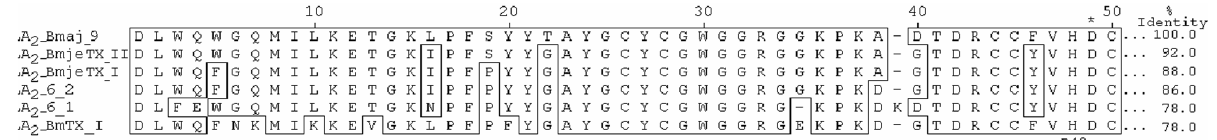
Figure 4. N-terminal amino acid sequence of Bmaj-9 compared with other Asp49 PLA B. marajoensis venom, 6-1 and 6-2 toxins from B. jararacussu venom and BmTX-I from B. moojeni